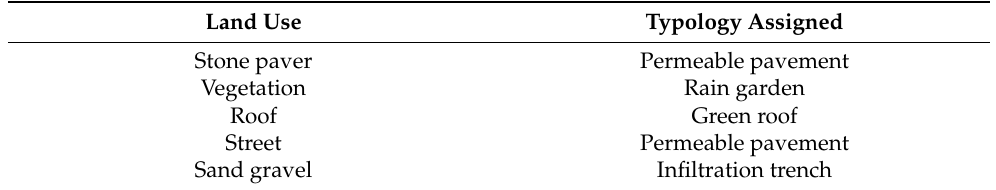
Figure 2. Optimization framework for SUDS definition. Table 5. Typologies assigned by land use.